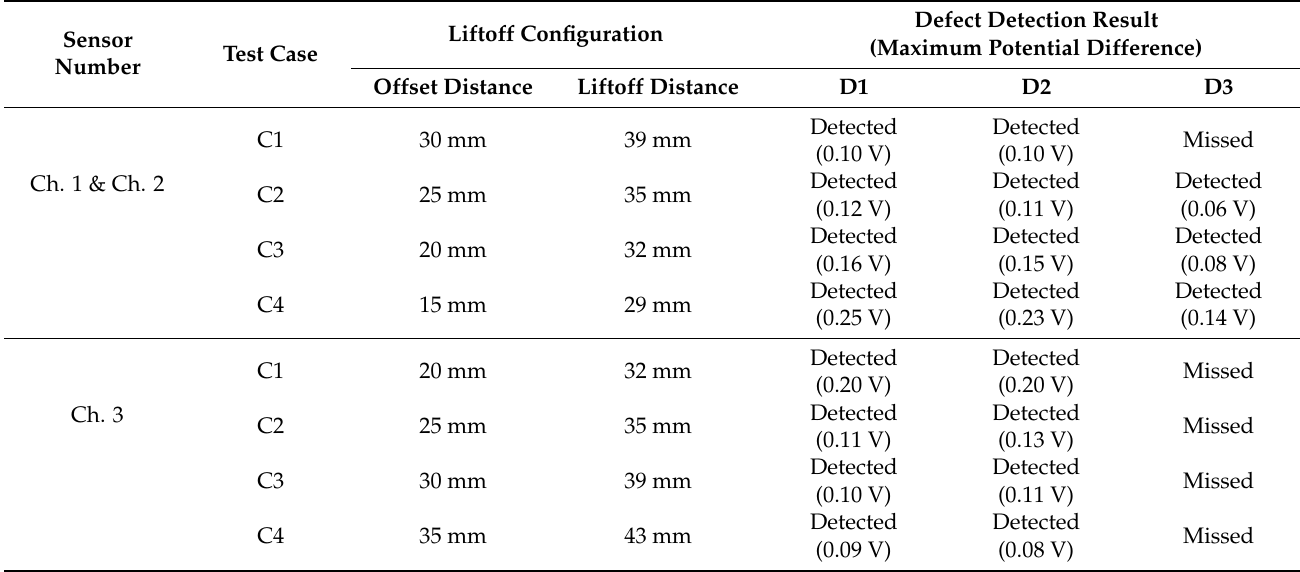
Table 4. Experimental